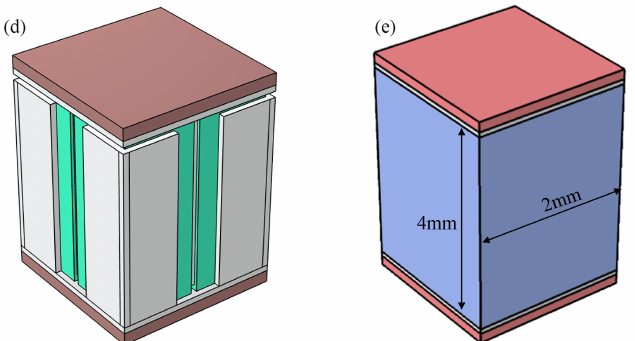
Figure 2. Geometry and electrode structure of the p-type group in the FFTEM module and TEM module. ( a , b ) are the electrode geometries of the p-type group in the FFTEM module; ( c ) is a p-type group with four identical thermoelectric legs; ( d ) is a complete p-type group in the FFTEM module; ( e ) is the p-type geometry of a TEM with the same volume of thermoelectric material as the ( d ).